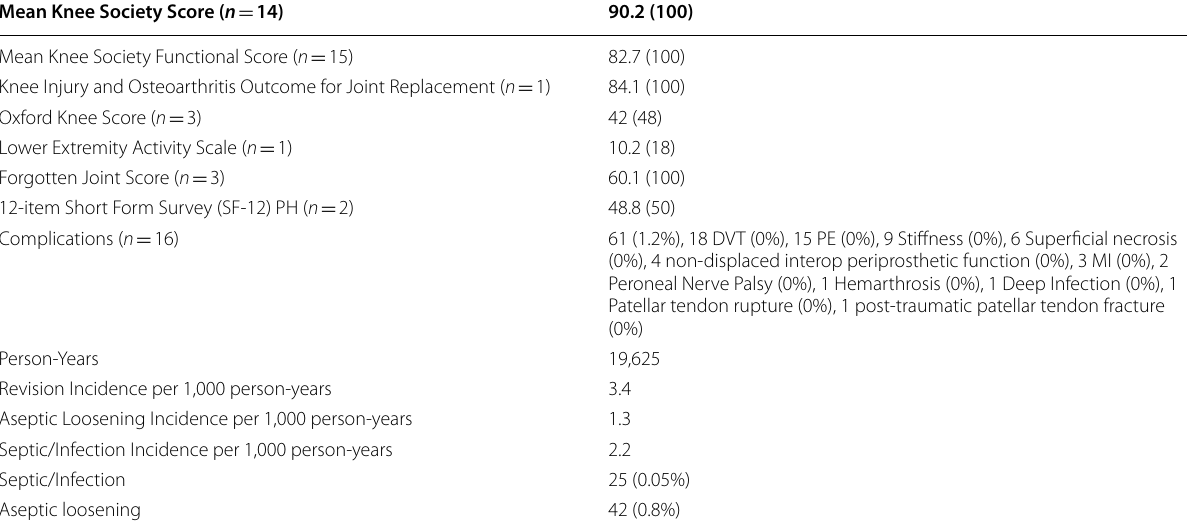
Table 3 Stryker triathlon cementless TKA functional outcomes, complications, and revision rates